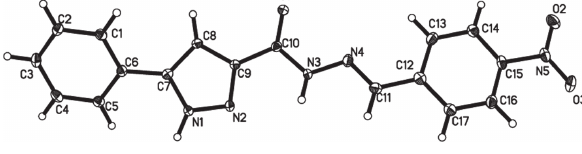
Table 1: Data collection and handling.